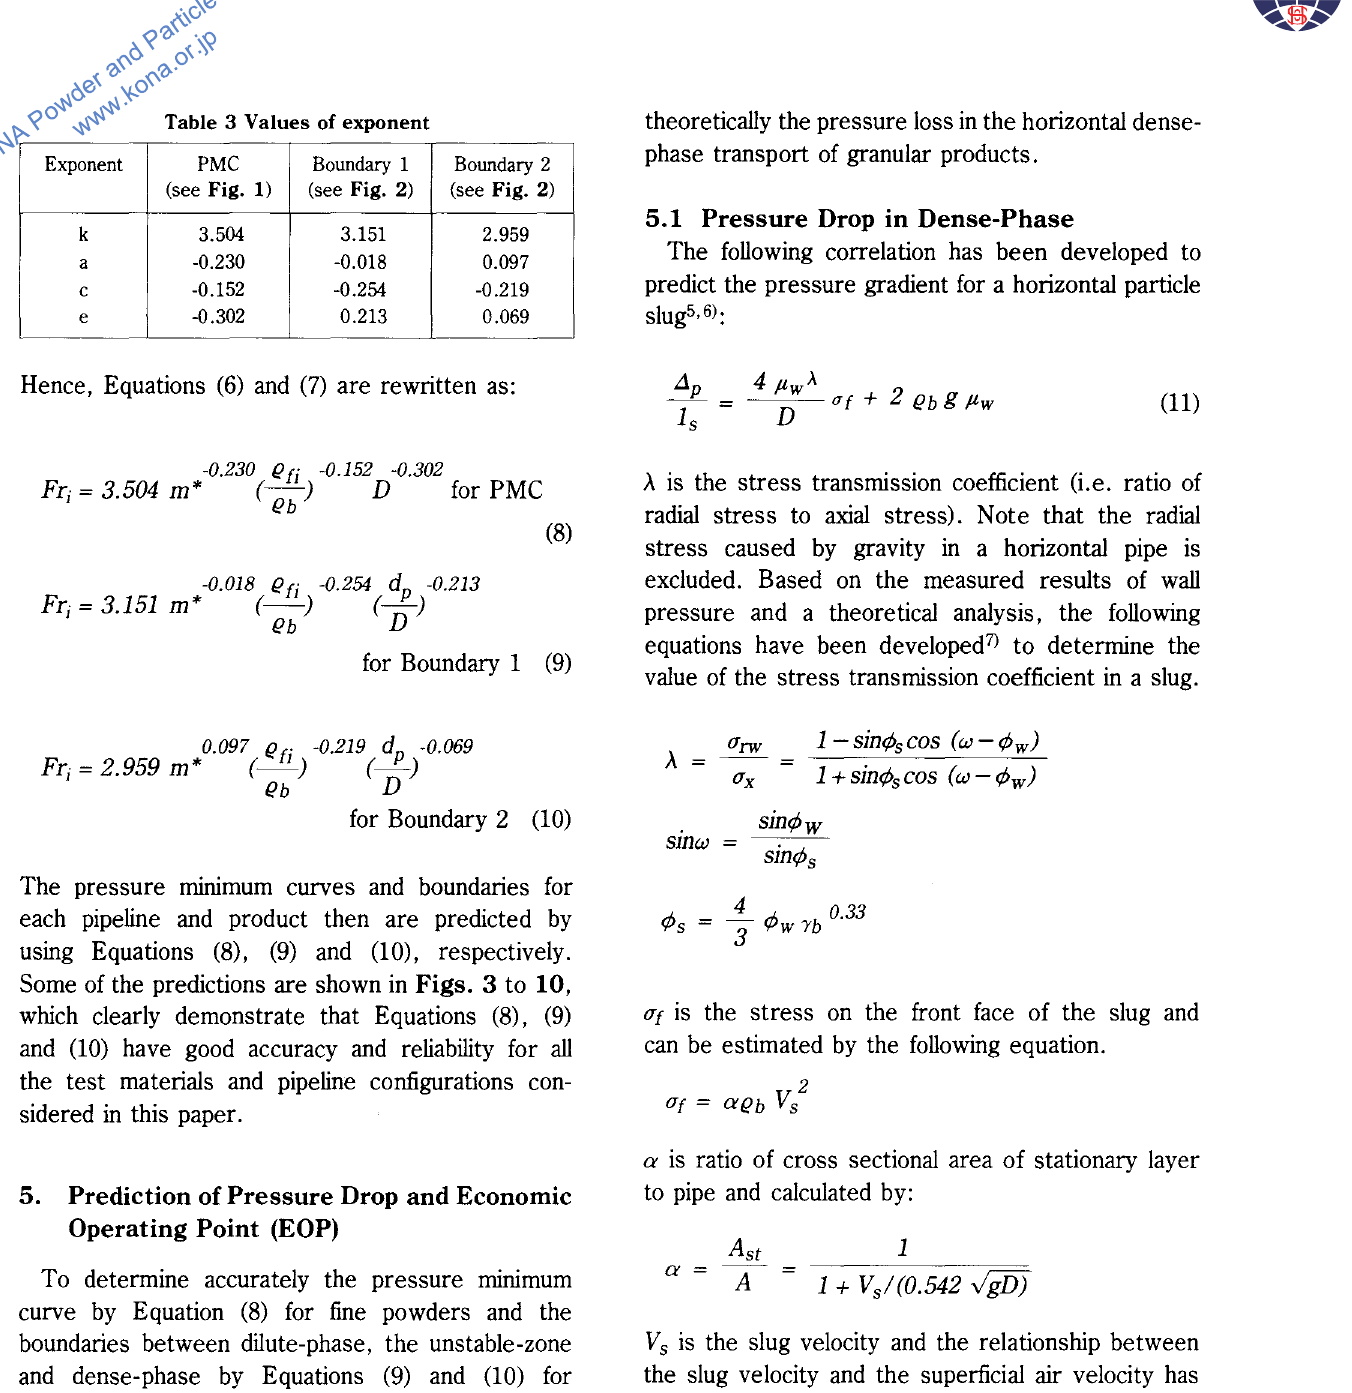
Table 3 Values of